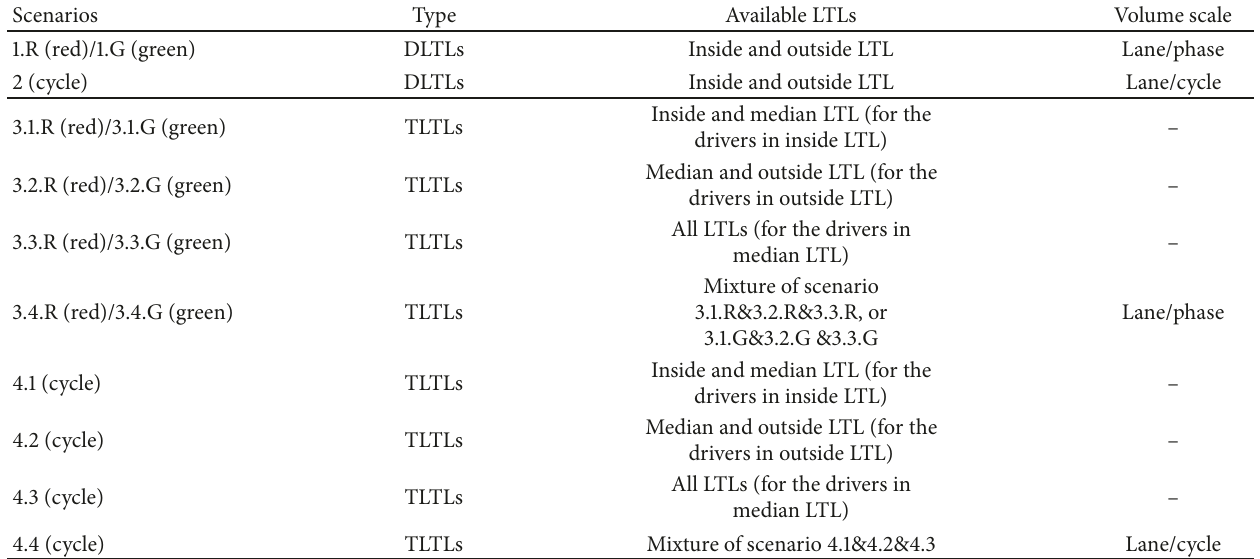
Table 1: Lane choosing scenarios at the DLTLs and the